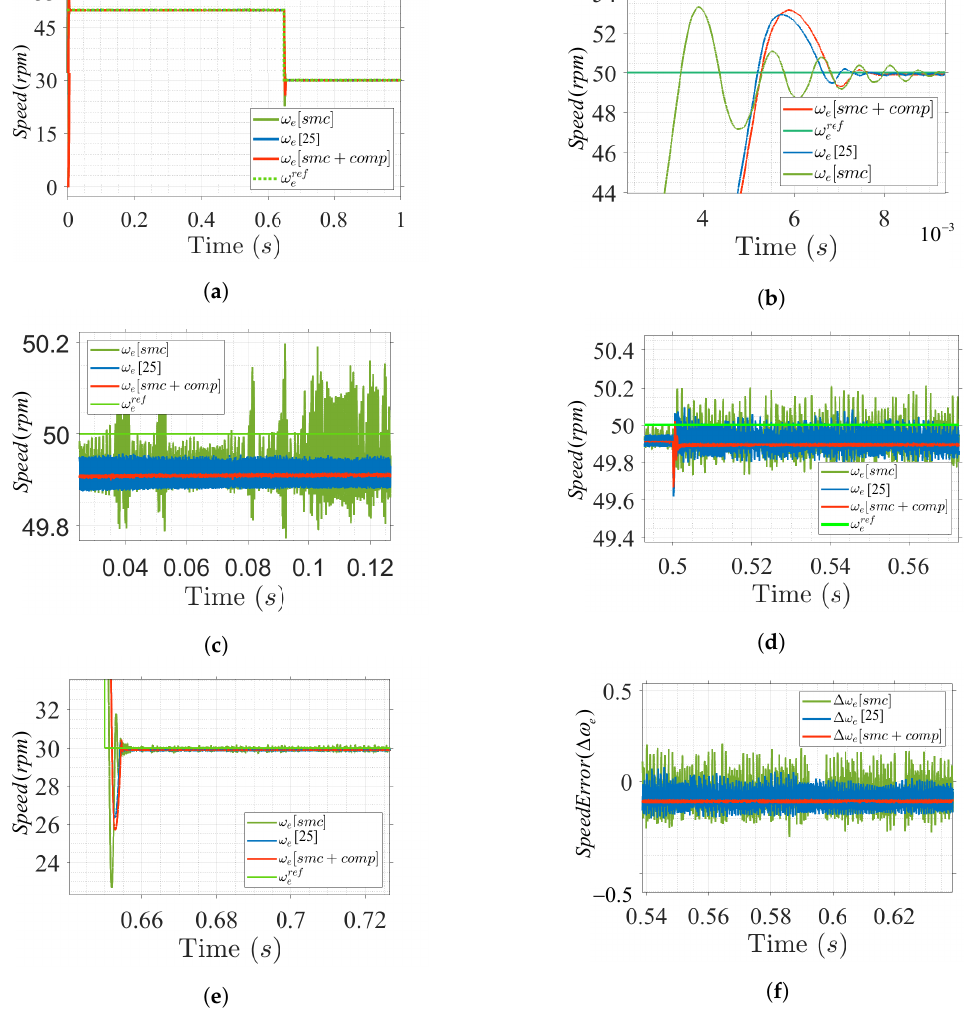
Figure 6. Speed profile at low speed operating range under load variation. ( a ) Speed response. ( b ) Speed overshoot. ( c ) Speed steady-state response. ( d ) Speed during load applied. ( e ) Speed at 30 rpm. ( f ) Steady-state speed error.